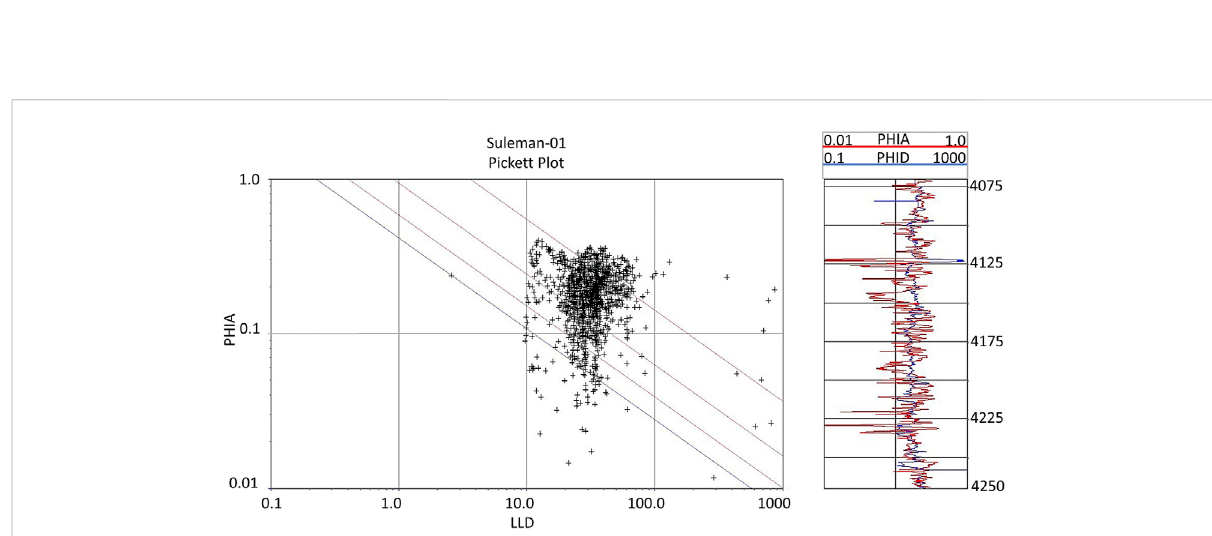
FIGURE 6 Computation of formation water resistivity R w from 4075 to 4250 m reservoir interval through the Pickett plot method using average porosity (fraction) and latero log deep resistivity (ohmmeters) curves.